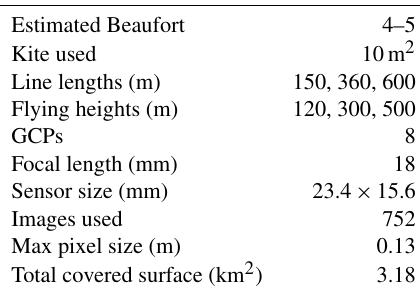
Table 2. Flight conditions and characteristics of the photogrammet- ric